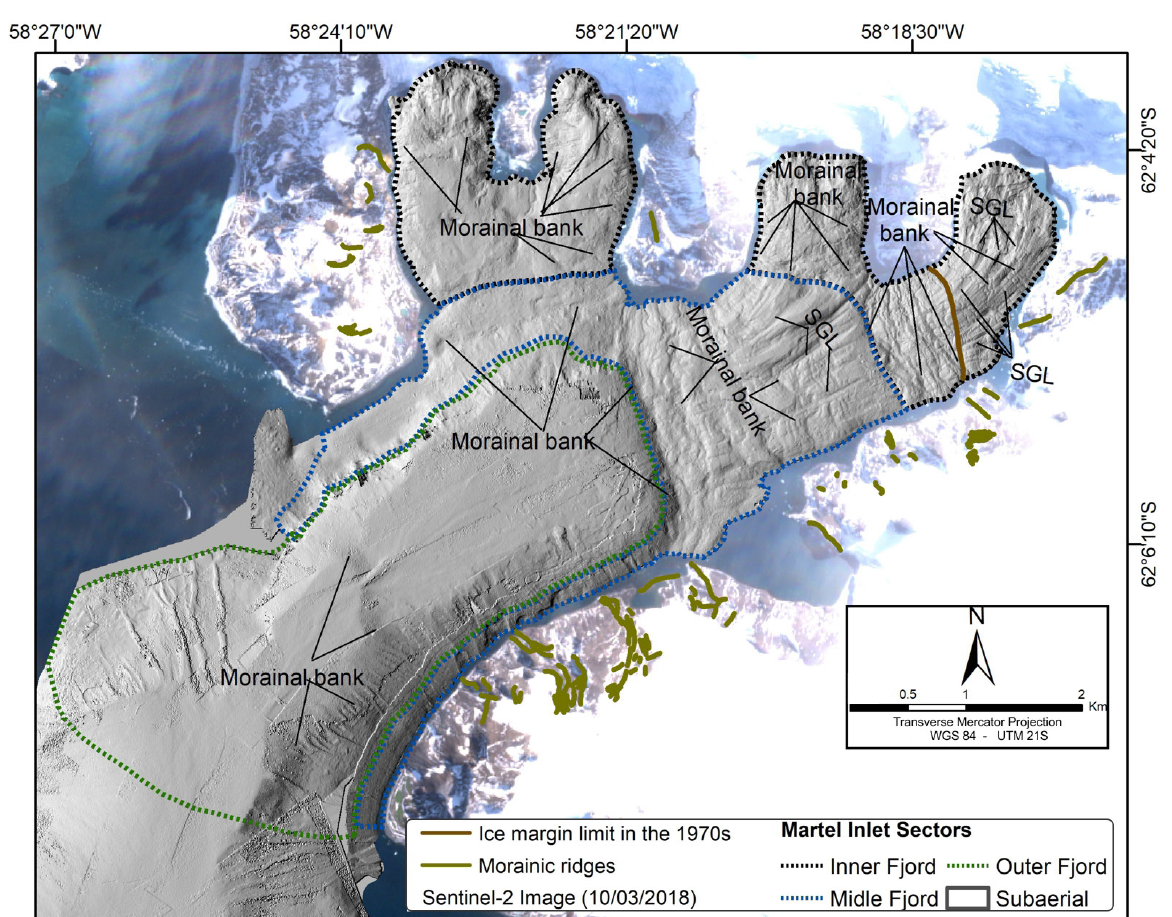
Figure 7. Streamlined glacial lineations (SGL) and ice-marginal landforms identification in shaded relief visualization of multibeam bathymetry data, overlaid on Sentinel-2 image collected in